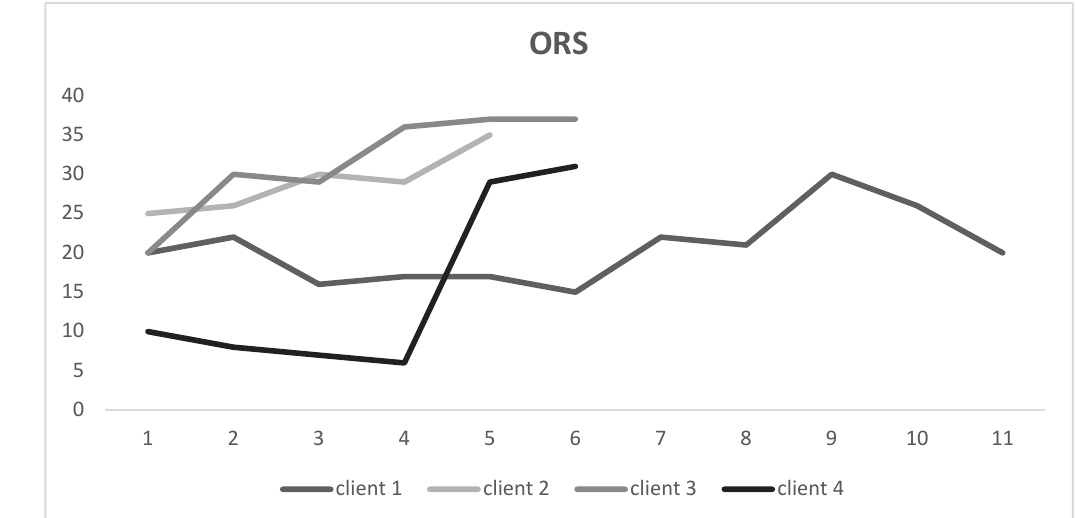
Figure 2. Change in Outcome Rating Scale (ORS) scores during treatment.